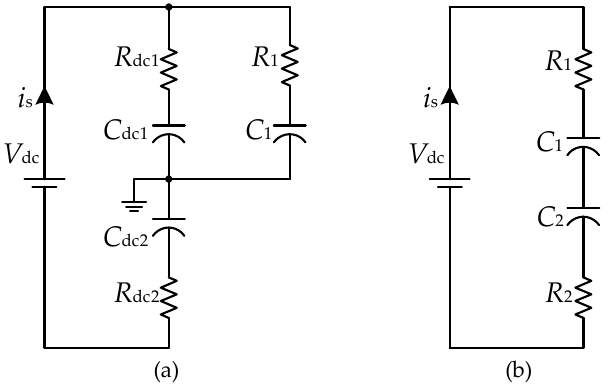
Figure 3. Equivalent circuit of ( a ) approach I and ( b ) approach II.